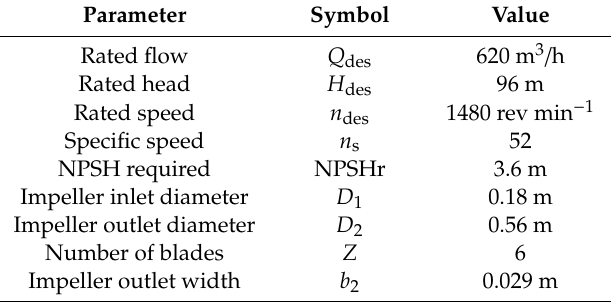
Table 1. Basic parameters of the research